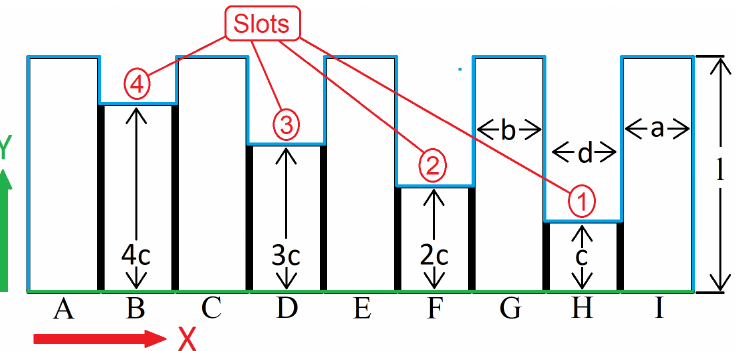
Figure 3. PMMA sample and its slots.